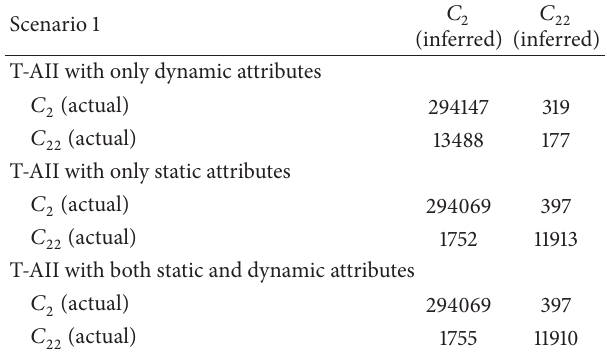
Table 3: Confusion matrix in scenario